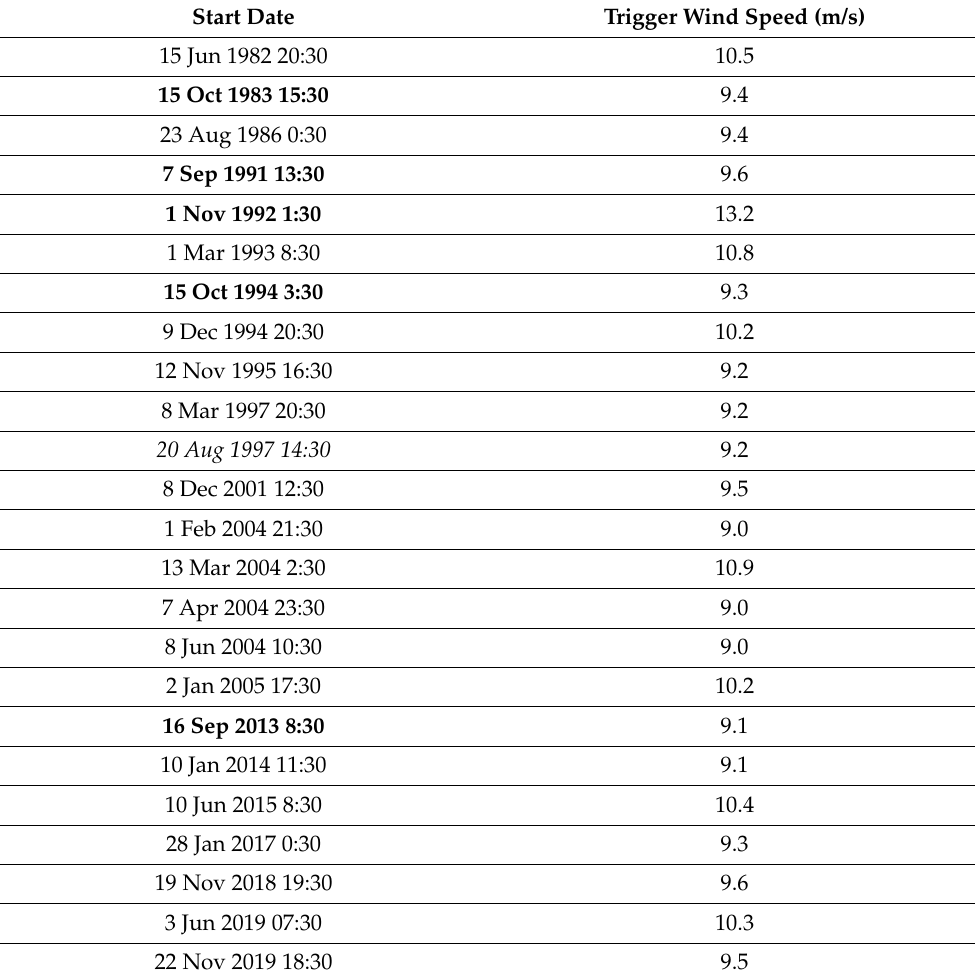
Table 1. Start date and trigger event wind speed for each of the identified windspeed sequences displayed in Figure